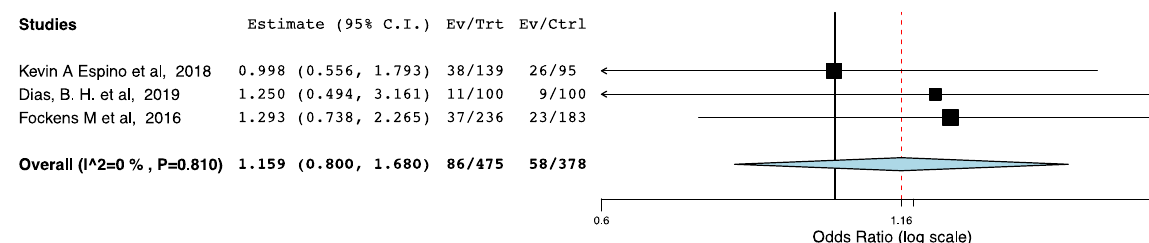
Figure 9. Forest plot: unplanned readmissions (ERAS—traditional perioperative care).